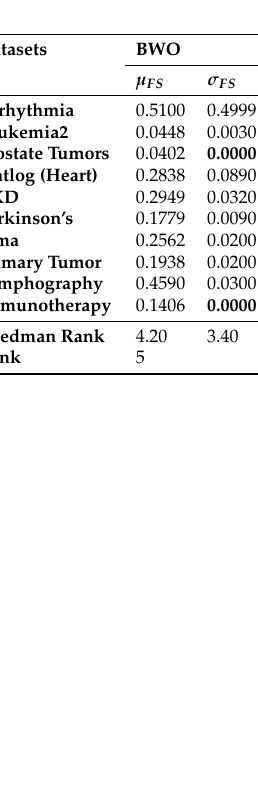
Table 9. Comparison of the FS between OBWOD and other optimization algorithms based on the kNN